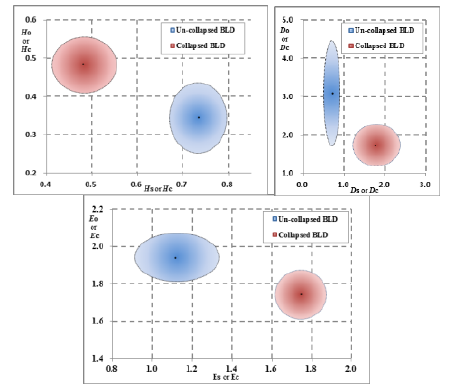
Figure 2. The mean and standard deviation of texture’s in layover and shadowing areas of un-collapsed buildings, and the collapsed area of buildings. H , D , E refers to homogeneity, dis- similarity and entropy separately; o, s refers to layer-over & shadow areas separately for un-collapsed building; c refers to collapsed area of collapsed building (Cui et al, 2016) .